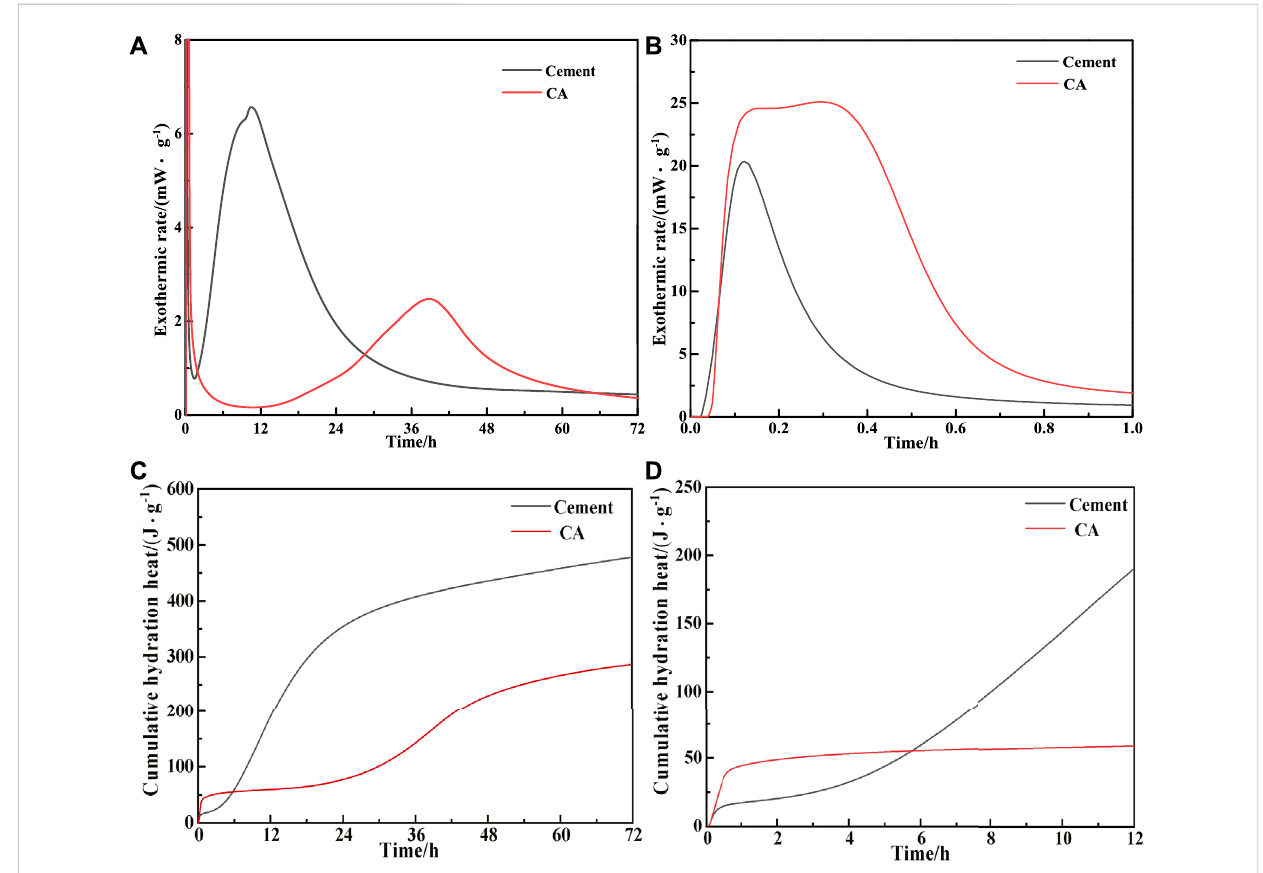
FIGURE 8 Calorimetry curves of the cement paste and CA paste. (A) and (B) heat fl ow; (C) and (D) cumulative heat.